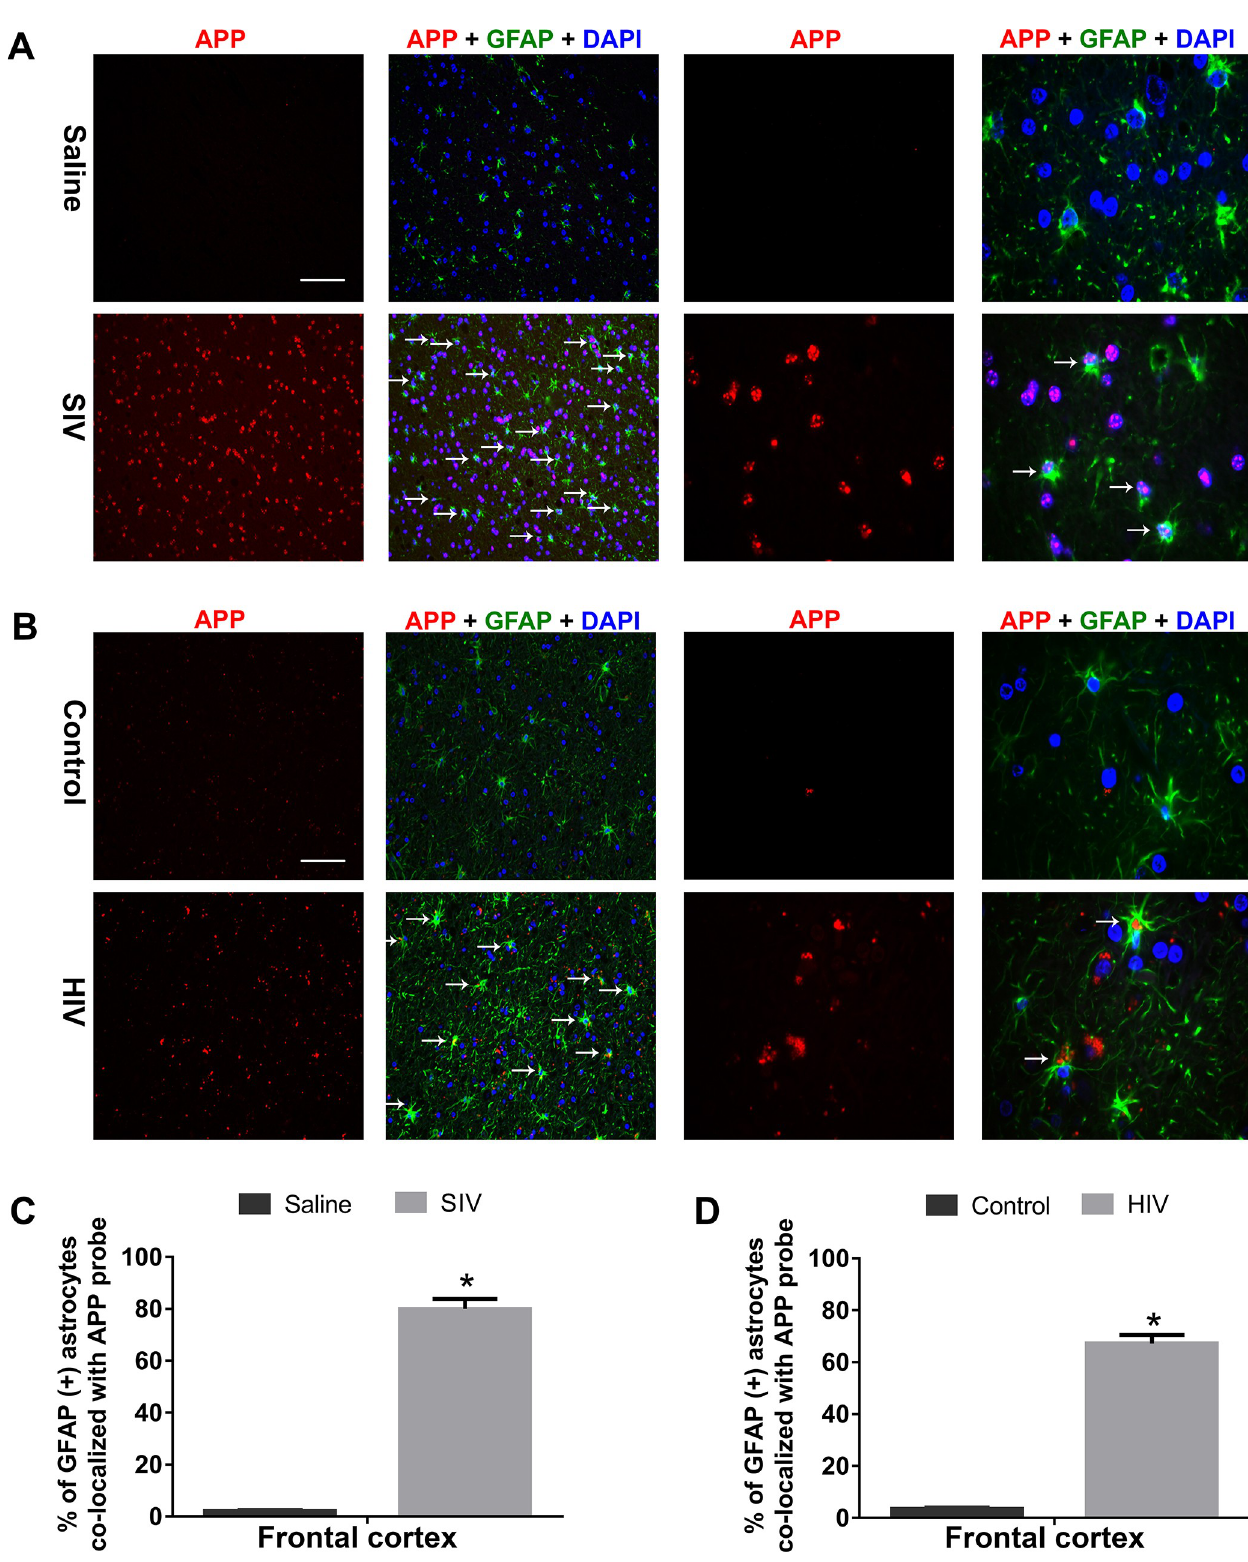
Fig 4. Expression of APP RNA by in situ hybridization in the FCs of SIV-infectedmacaques and patients who are infected with HIV. Representative FISH and IF photomicrographs showing differential expression of APP RNA in GFAP + astrocytes in SIV + macaques (A) and patients who are HIV positive